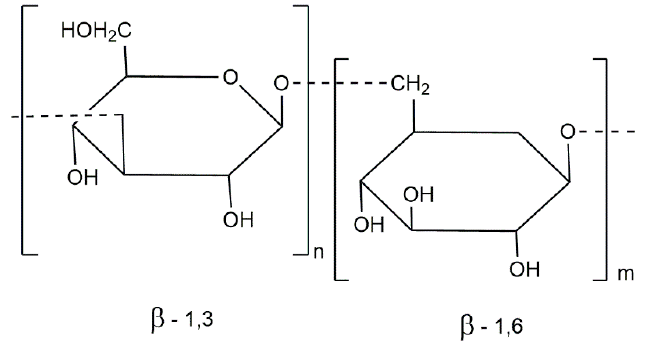
Figure 4. Laminarin structure [77]. Table 3. Overview of the in vitro and/or in vivo hypocholesterolemic effect of polysaccharides isolated from different brown algae species under different extractions conditions. Isolated